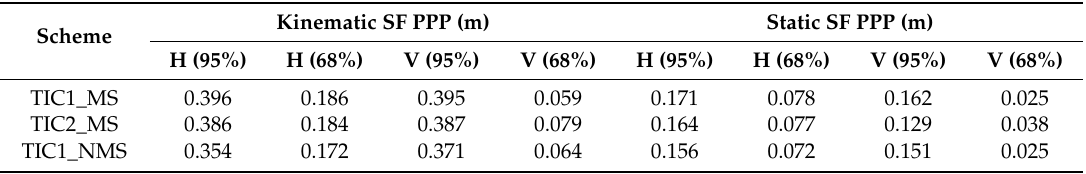
Table 7. The RMS of GPS static and kinematic SF PPP in MS and NMS of TIC1 or TIC2.